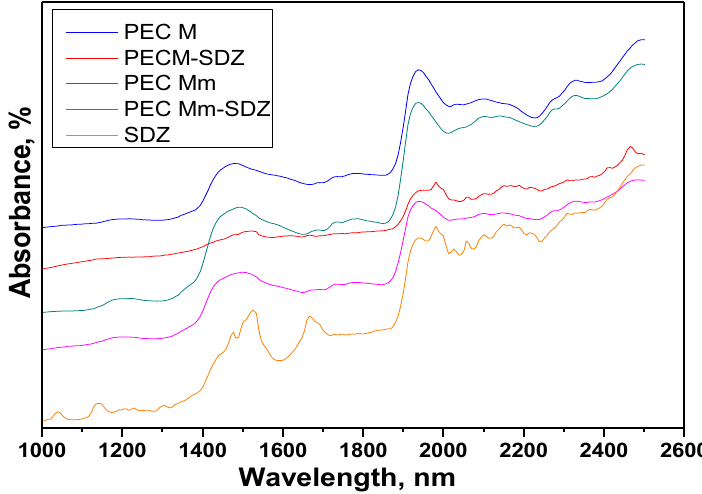
Figure 7. Compared Near-IR reflectance spectra of the polyelectrolyte complexe (PEC) sponges prepared without added sulfadiazine (SDZ) and of SDZ-loaded PECs (PEC M and PEC